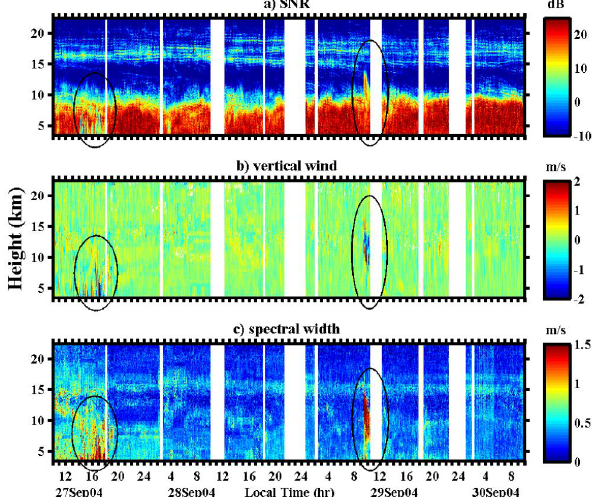
Figure 3. Height-time section of (a) SNR, (b) vertical wind velocity (ms -1 ) and (c) spectral width 651 Fig. 3. Height–time section of (a) SNR, (b) vertical wind velocity (ms − 1 ) and (c) spectral width (ms − 1 ) derived from the vertically (ms -1 ) derived from the vertically pointed radar beam (Z x ) for 27-30 September 2004 and the 652 pointed radar beam (Z x ) for 27–30 September 2004, and the demar- demarcated area inside circles and ellipses corresponds to thunderstorm and squall line passages 653 cated areas inside circles and ellipses correspond to thunderstorm over Gadanki. 654 and squall line passages over Gadanki.